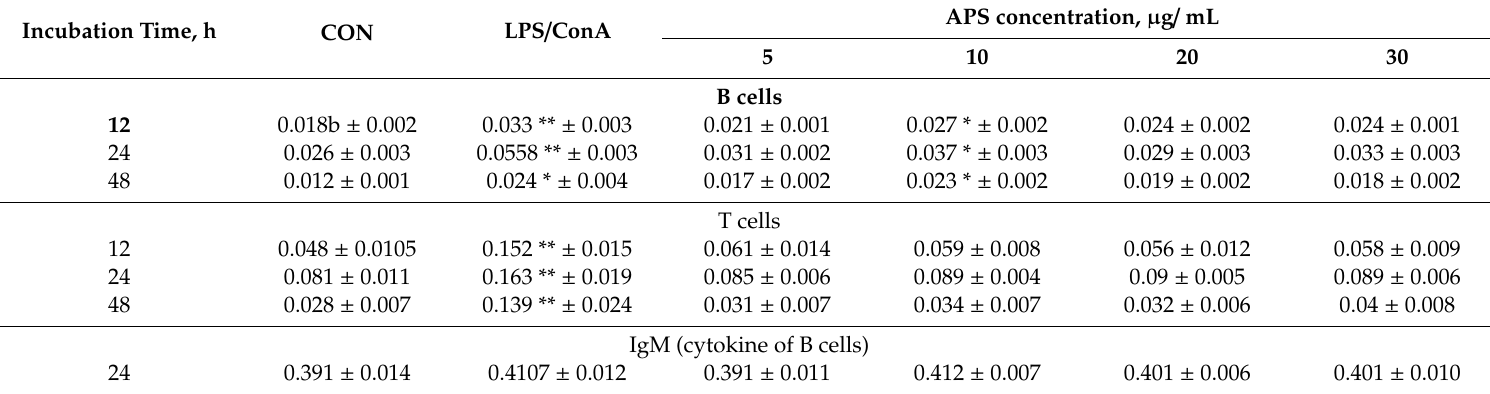
Table 4. E ff ects of APS on the proliferation of B and T cells, and the IgM concentration in cultured B cells (OD values at 490 nm) 1 . Incubation Time,